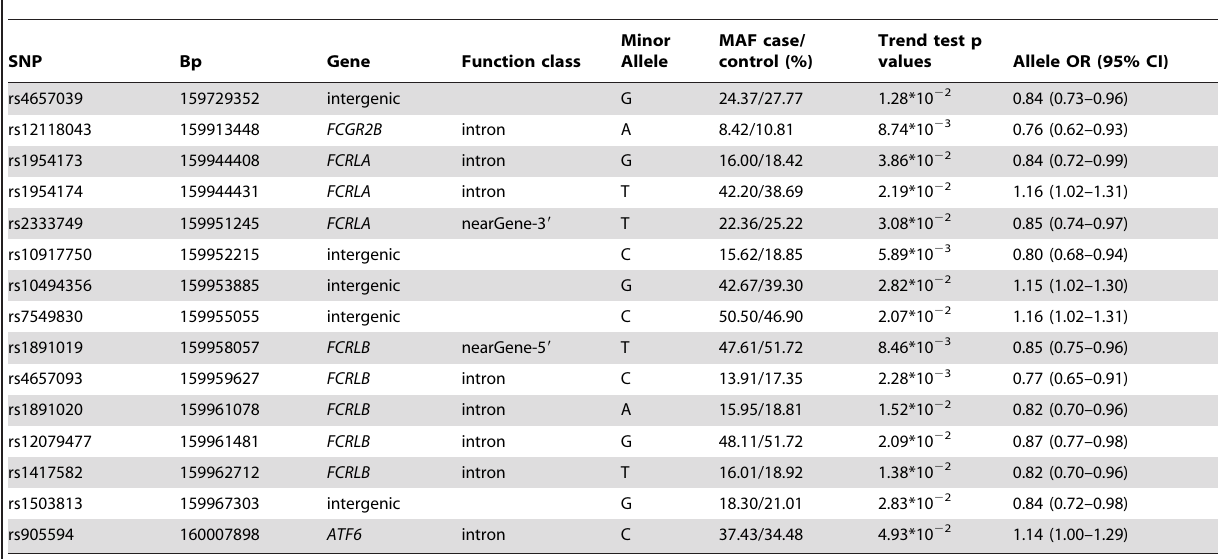
Table 1. Associations between FCGR gene polymorphisms and susceptibility to